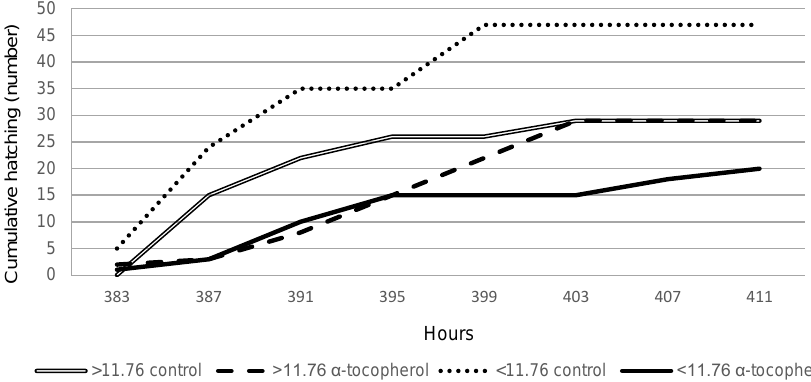
Figure 1. The effects of egg weight (<11.76, >11.76) and in ovo administration (control, α -tocopherol) on the cumulative hatching of quail